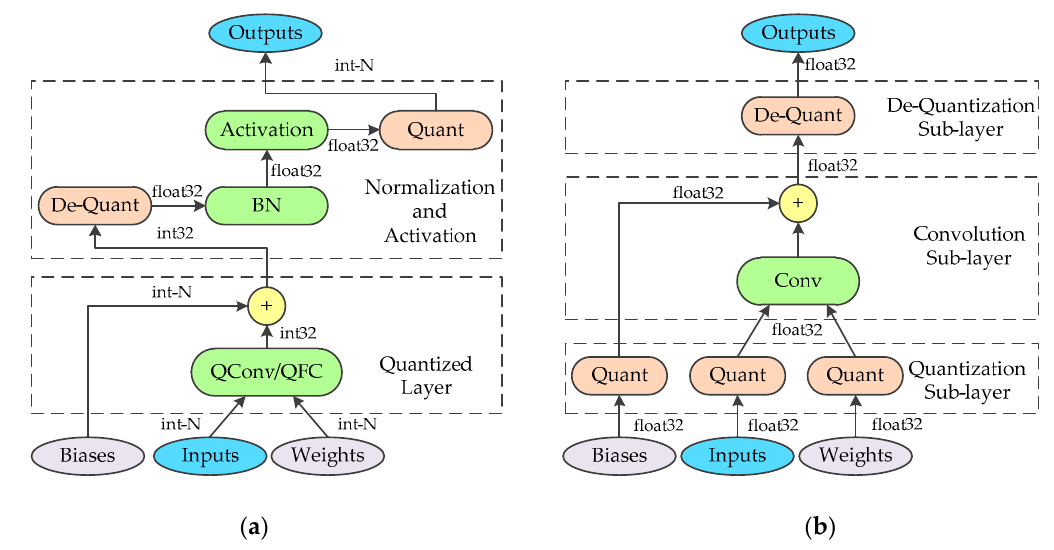
Figure 1. ( a ) Integer/floating-point hybrid-type inference in FPGA. ( b ) The architecture of the quantized convolutional layer during training.